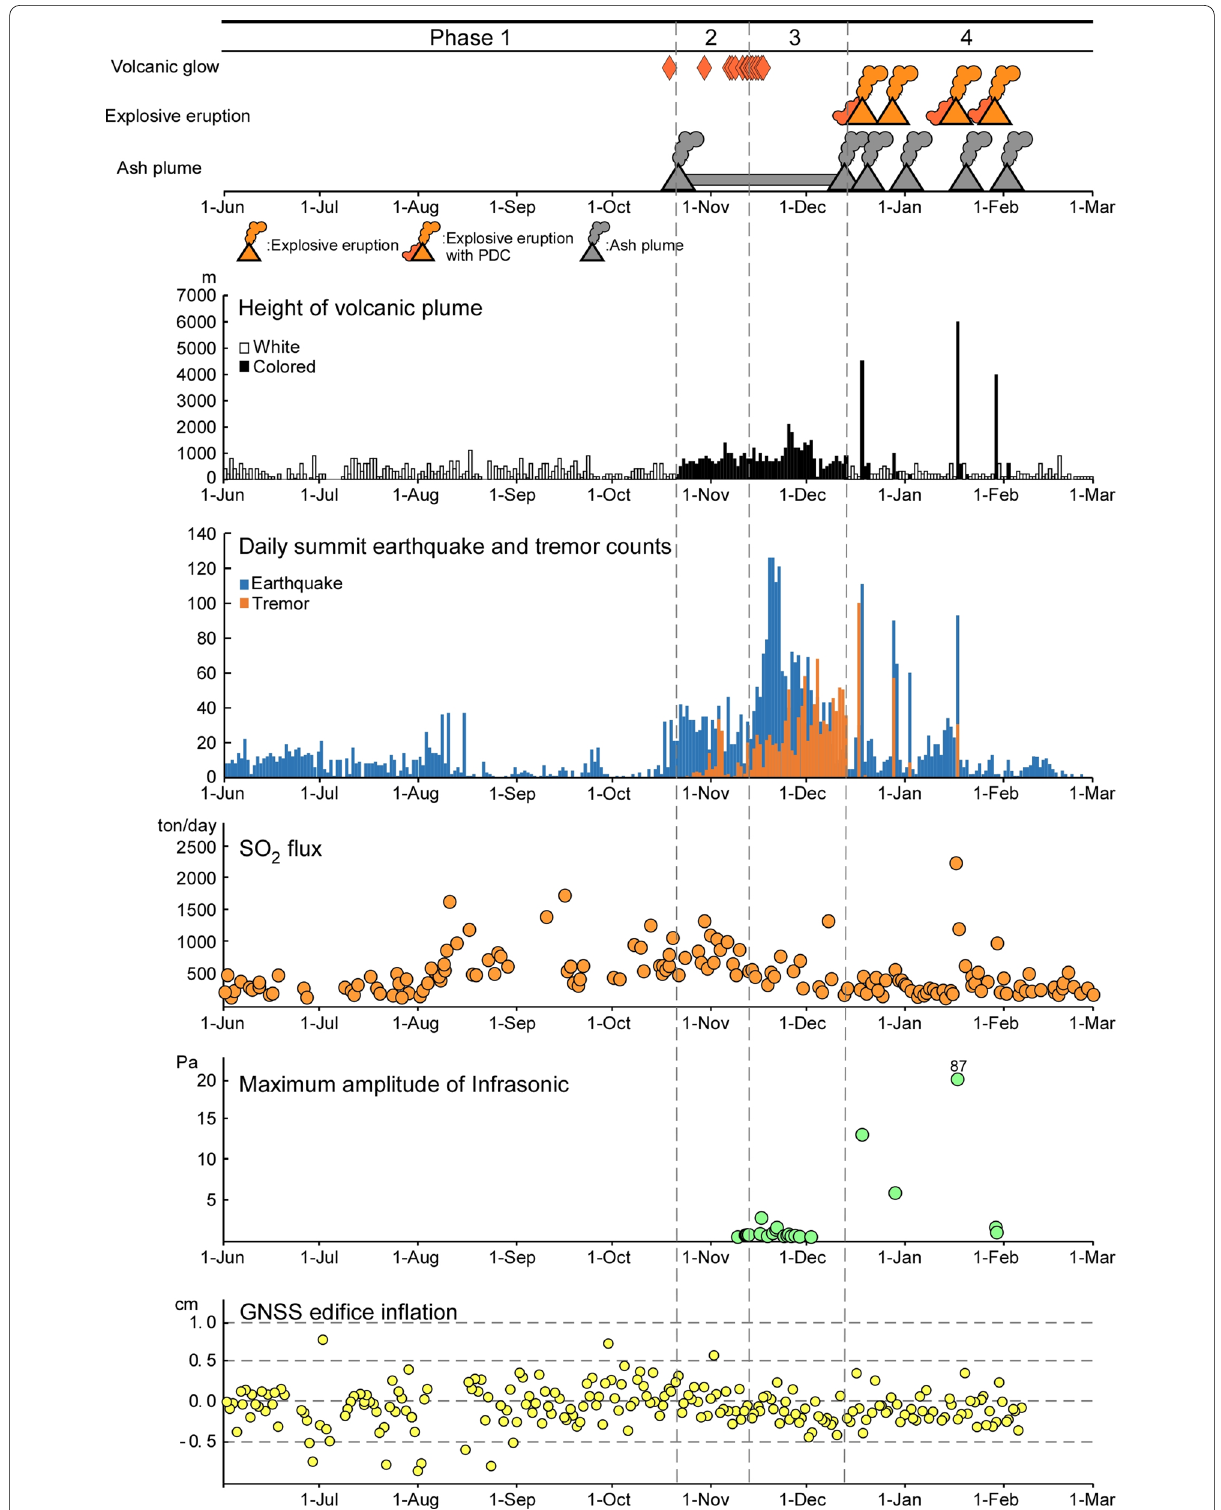
Fig. 2 Timeline of monitoring data for the 2018–2019 eruption of Kuchinoerabujima Volcano ( modified from Sugai et al.,